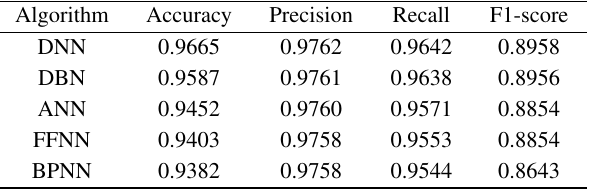
Table 4 Performance of nelfinavir drug interaction with SARS-CoV-2 virus over Indian datasets.